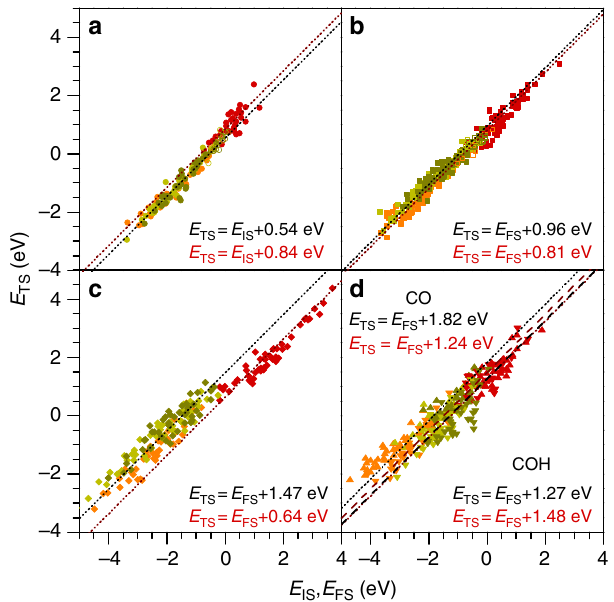
Fig. 3 Best linear scaling relationships. a Initial state scaling relationships for O – H bond breaking on Ru, Pd, and Pt (black dotted line) and Cu (red line). Final state scalings for b C – H, c C – C, and d C – O/C – OH bond breakings. The α (slope) values in the linear scaling relationships were set to